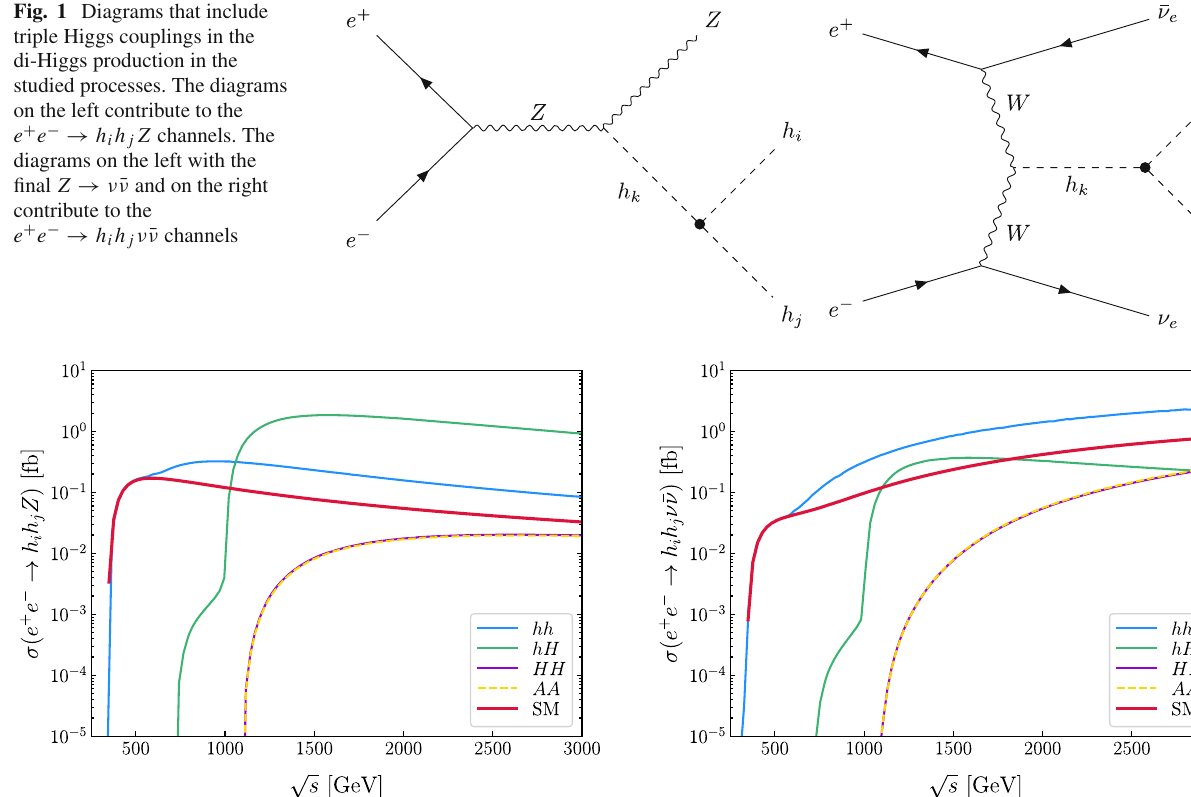
Fig. 2 Crosssectionsasafunctionofthecenter-of-massenergy the processes e + e − → h i h j Z (left) and e + e − → h i h j ν ¯ ν (right) for the particular point of the 2HDM type I defined by the input parameter values: m H = m A = m H ± = 500 GeV, tan β = 10, c β − α = 0 . 2, and